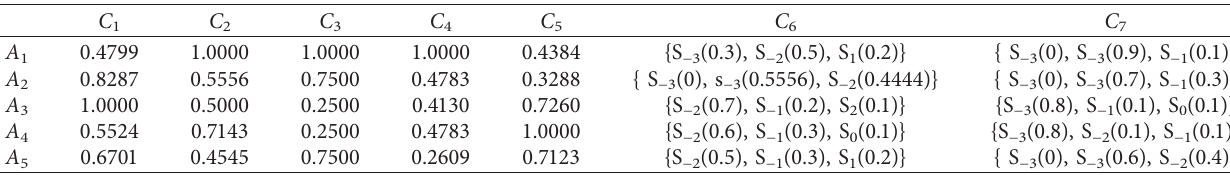
Table 2: Normalized data information.